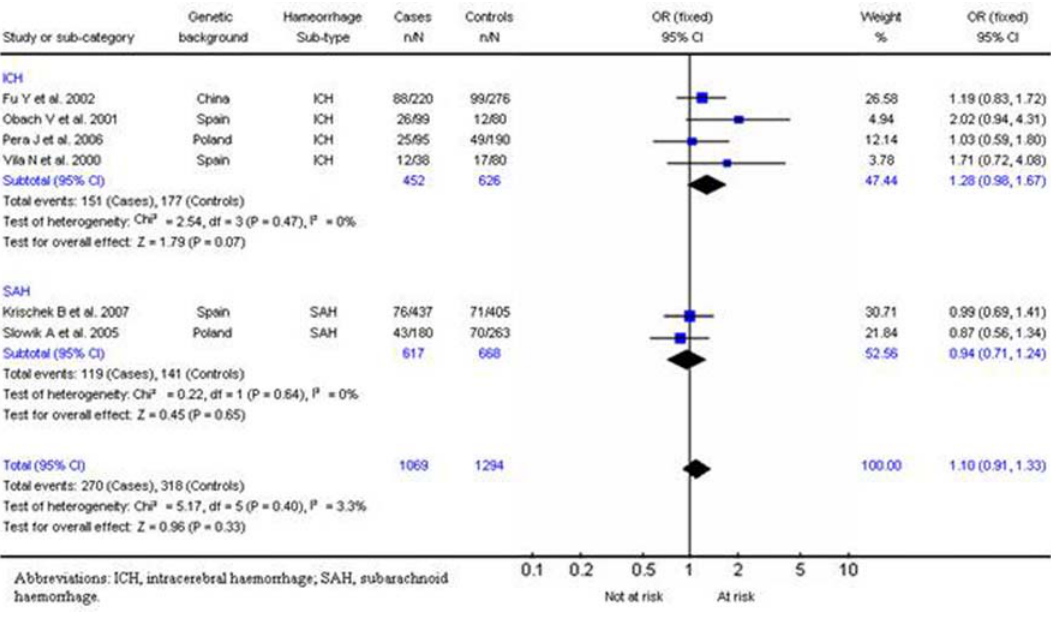
Figure 6. Results for SERPINA3/TT in haemorrhagic stroke.